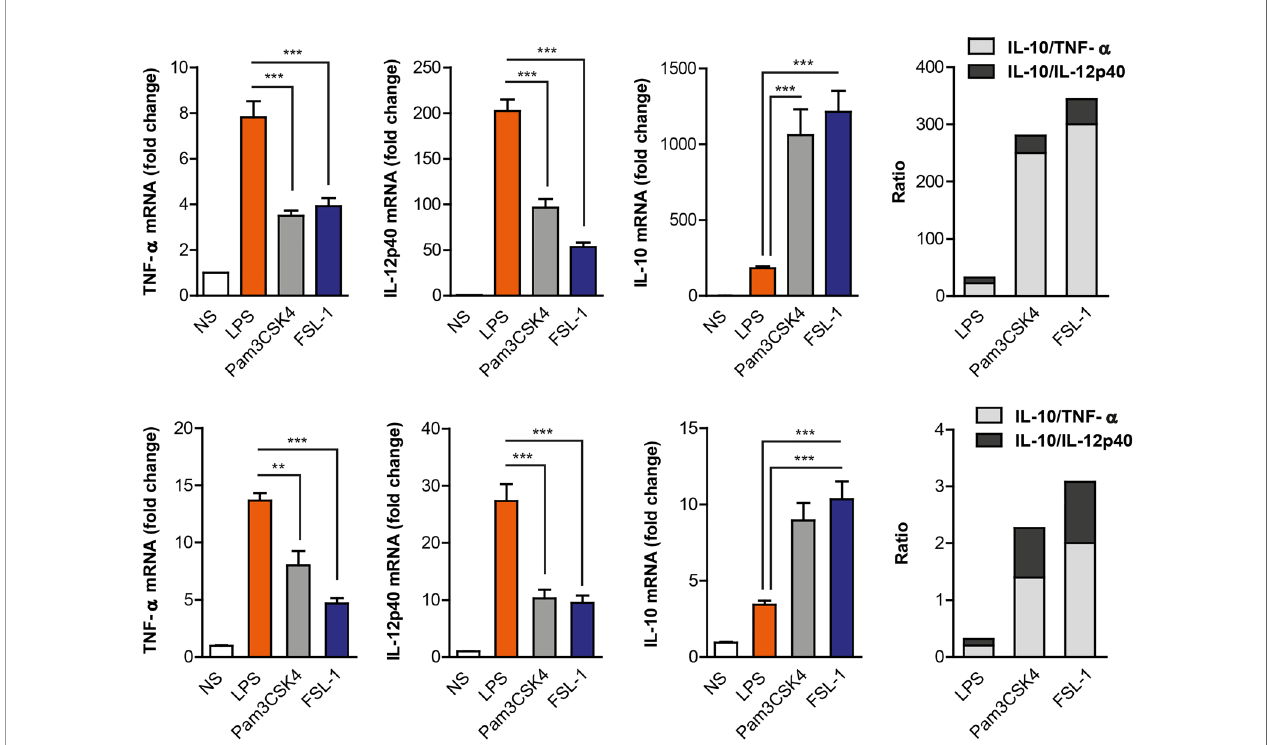
FIGURE 1 | TLR4 and TLR2 ligands induce a distinct cytokine expression pattern in Raw264.7 cell line and peritoneal macrophages. Raw264.7 cells (upper graph) and mouse peritoneal macrophages (lower graph) were stimulated with LPS (100 ng/mL), Pam3CSK4 (1 µg/mL) and FSL-1 (100 ng/mL) for 24 h. Cytokine ’ s mRNA expression was assayed by quantitative RT-PCR, normalized to RPL13A, and presented relative to unstimulated cells (NS). Data shown is from a representative experiment of the three independent experiments performed from triplicate cultures (mean ± SEM) (**p < 0.01 and ***p <